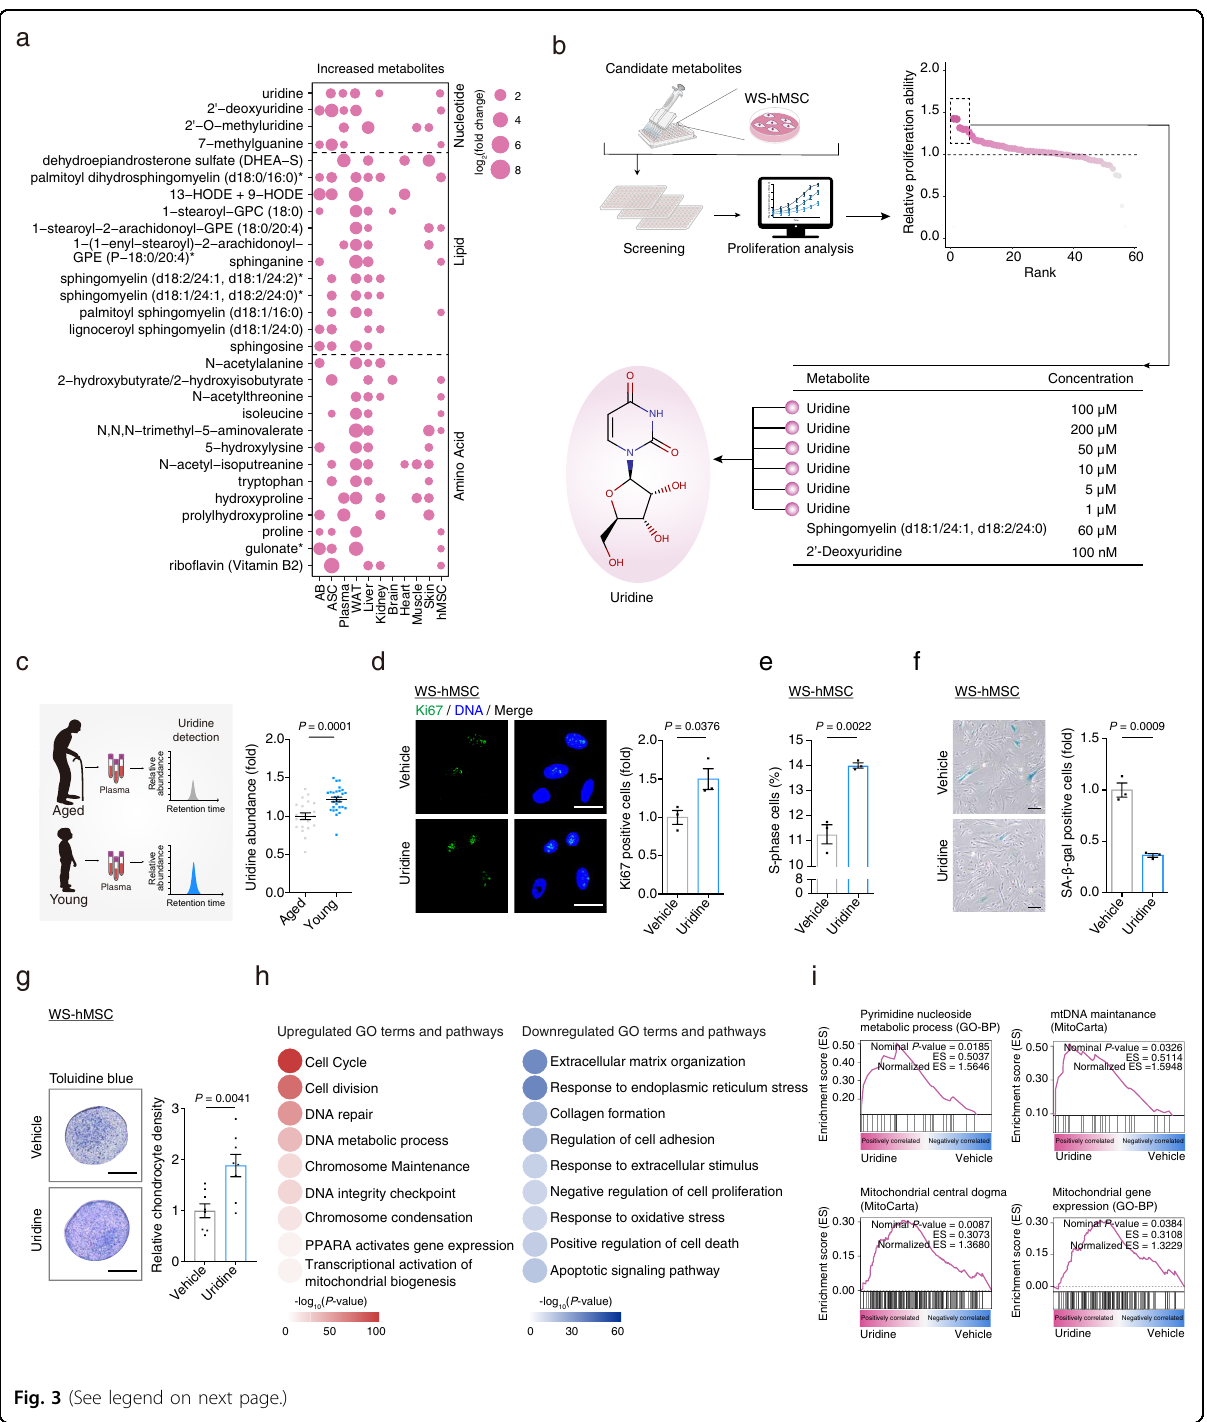
sphingomyelin (d18:1/24:1, (d18:1/24:0)palmitoyl sphingomyelin (d18:1/16:0) B2)gulonate*prolineprolylhydroxyprolinehydroxyprolinetryptophanN−acetyl−isoputreanine5−hydroxylysineN,N,N−trimethyl−5−aminovalerateisoleucineN−acetylthreonine2−hydroxybutyrate/2−hydroxyisobutyrateN−acetylalaninesphingosinelignoceroyl sphingomyelin